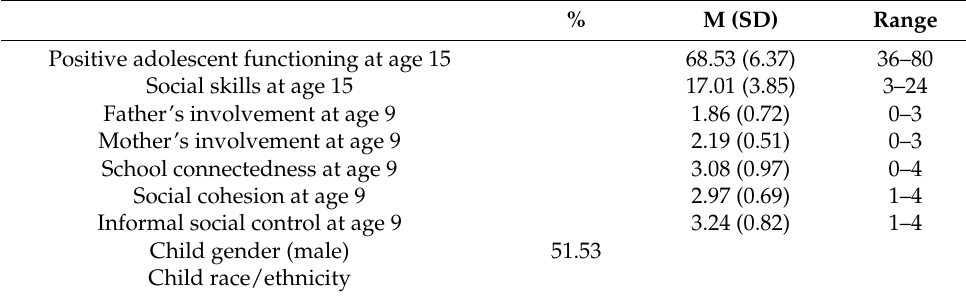
Table 1. Sample characteristics and descriptive statistics of study variables (N =